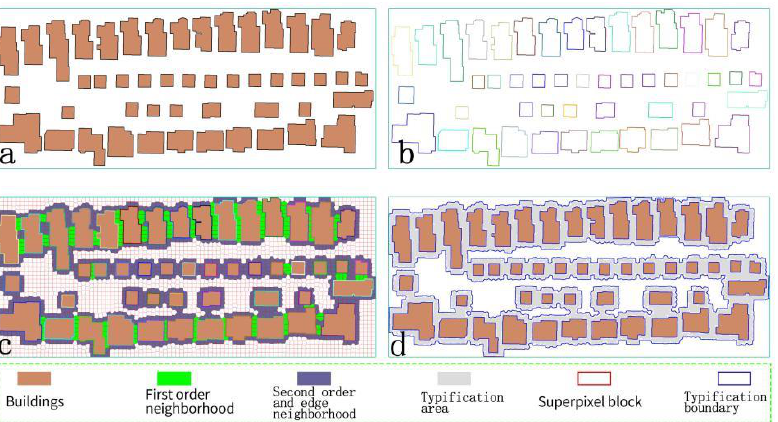
Figure 3. Second-order neighborhood clustering using superpixels for buildings. ( a ) Original buildings tile map. ( b ) Buildings connection boundary diagram. ( c ) Superpixel neighborhood graph. ( d ) Typicification area of buildings.